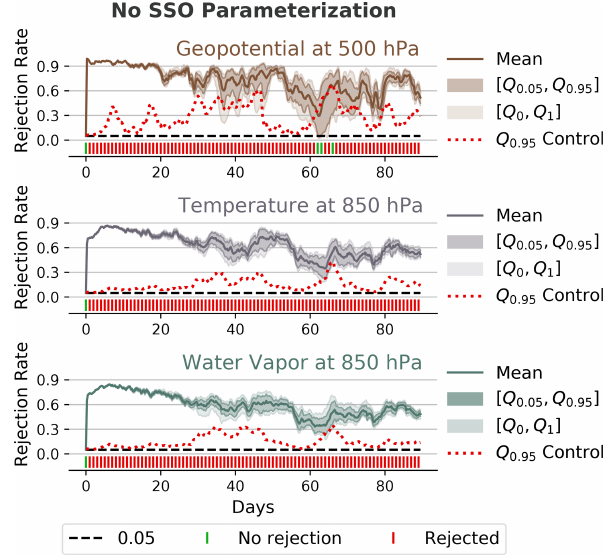
Figure 7. Rejection rates and decisions similar to Fig. 3 but for the 500hPa geopotential, 850hPa temperature, and 850hPa water vapor amount and for an evaluation ensemble where the subgrid- scale orography (SSO) parameterization was switched off ( n E = 50, n S = 20, m = 100). The methodology rejects the null hypothesis throughout all 90d, except in three instances for the 500hPa geopo- tential. The difference between the mean rejection rate of the evalu- ation ensemble and the 0.95 quantile of the control is quite large and persistent (also considering the relatively small ensemble and sub- sample sizes), which indicates that such a big change in the model is detectable for an even longer